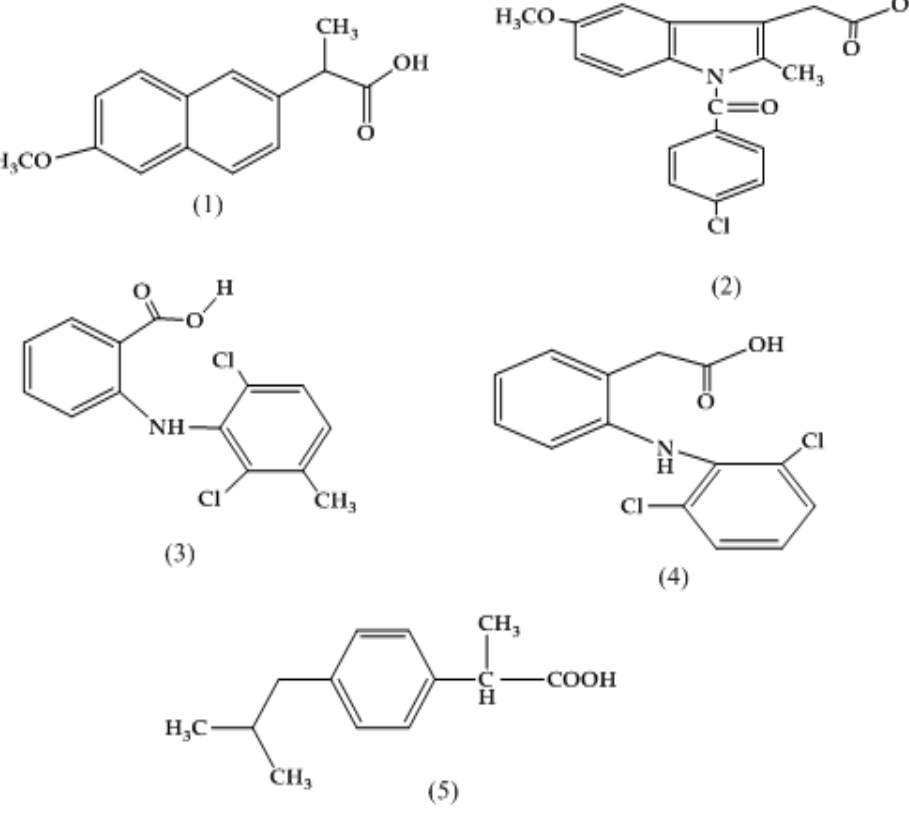
Figure 1: Chemical structure of some